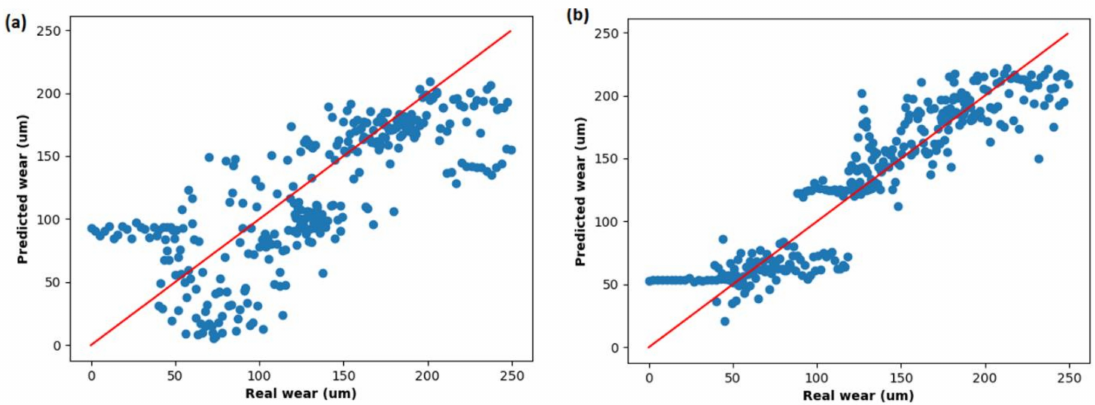
Figure 13. Predicted wear using RF versus real wear in using both ( a ) traditional features and ( b ) MR feature extraction (RF-RFE)